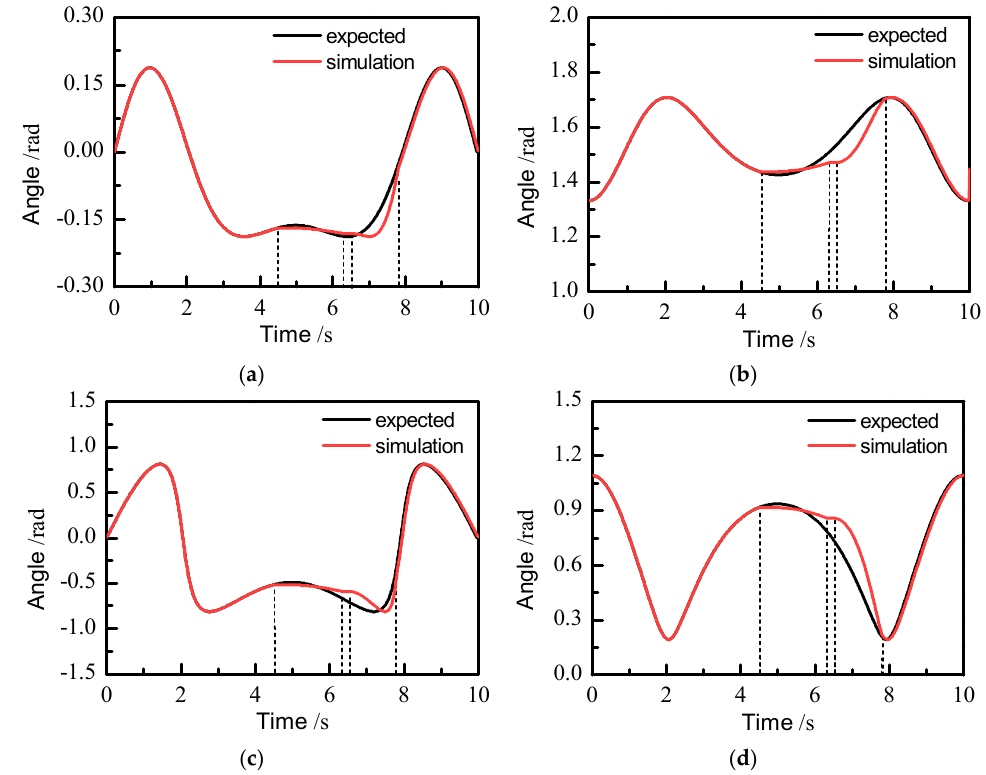
Figure 17. Output joint angles in the simulation model: ( a ) angle of joint 1, ( b ) angle of joint 2, ( c ) angle of joint 4, ( d ) angle of joint 5.